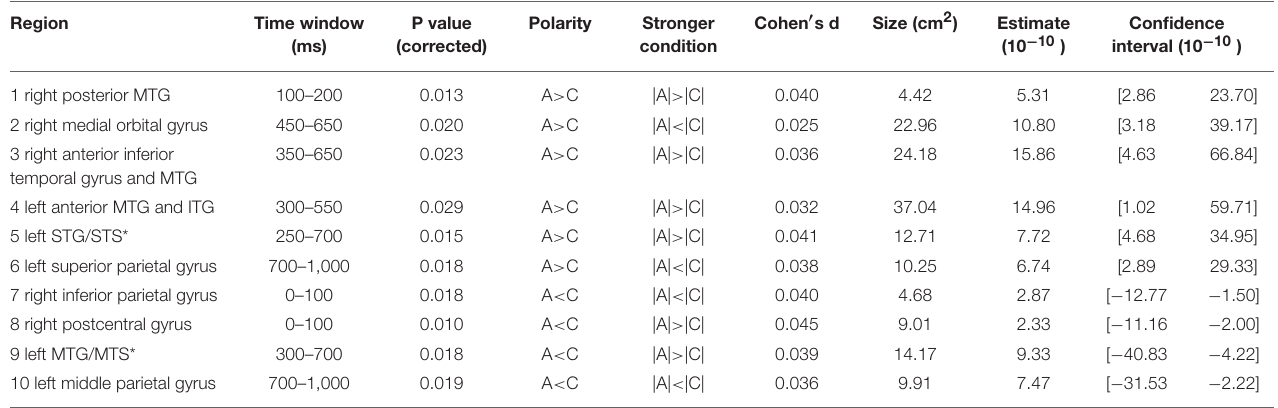
TABLE 2 | Statistical results for significance map of Figure 5 (abstractness).